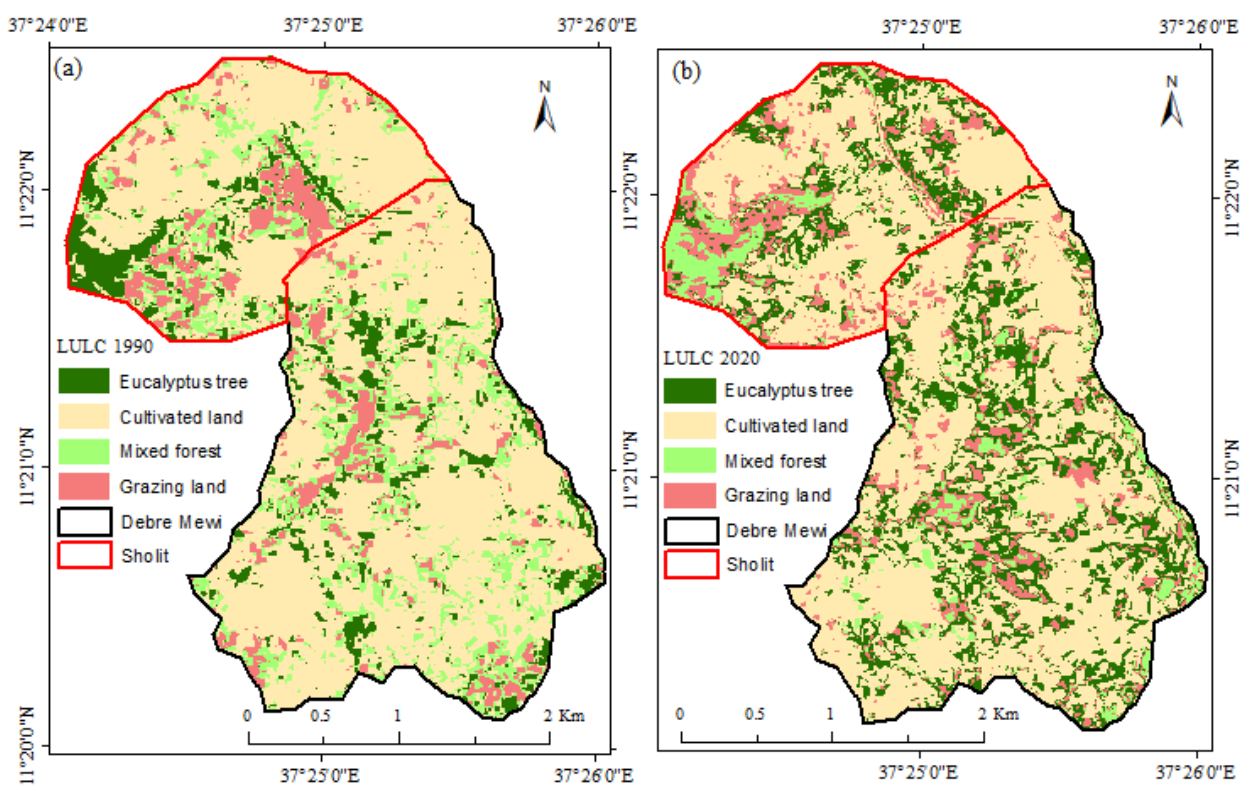
Figure 8. LULC maps of Debre Mewi (Bottom) and Sholit (Top) watershed ( a ) in 1990 and ( b ) 2020.